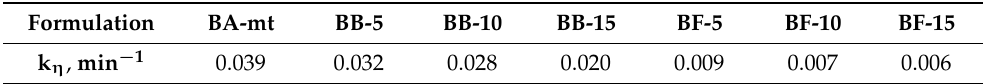
Table 4. The viscosity increase rate constants of compositions under study.